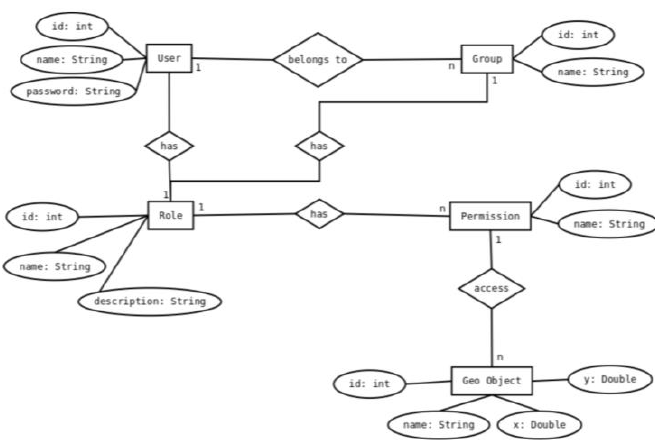
Figure 4. Abstract scheme of an ACL